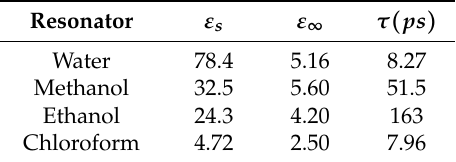
Figure 12. ( Δ f / fr ) for water, methanol, ethanol, and chloroform vs ε 1 -1 ( a ); and ( Δ f B / f r ) for the same solvents vs. ε 2 ( b ).